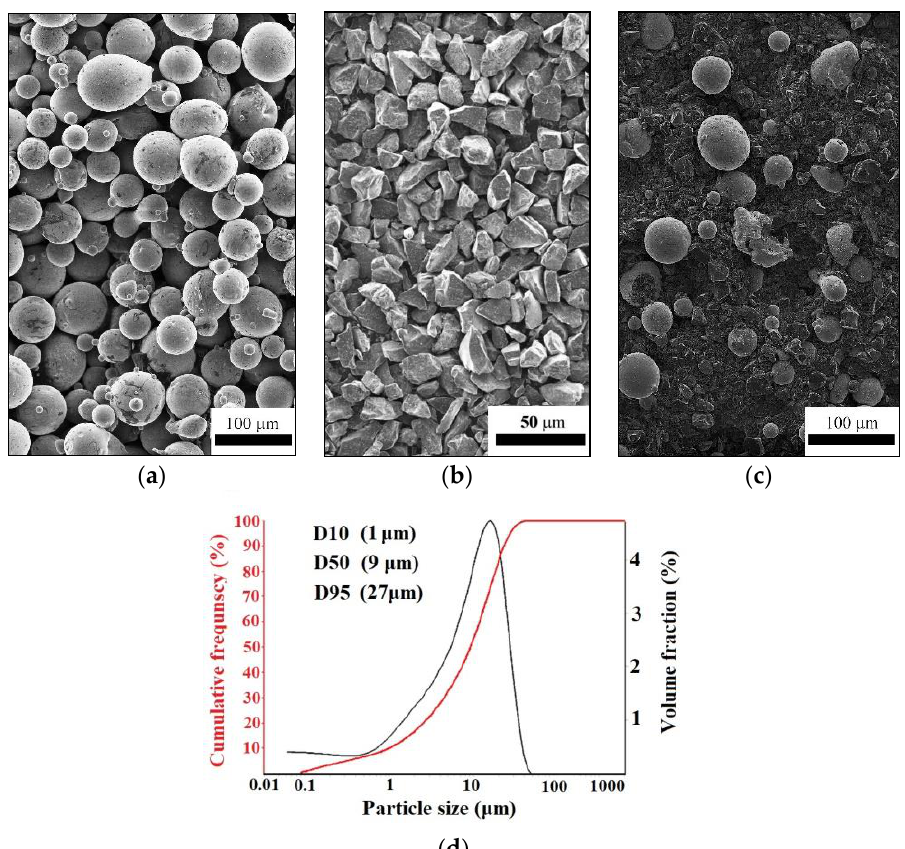
Figure 1. Morphology and particle size of the initial powders and their compositions. Powder morphologies: AP-NiCr17Si4B4 ( a ), B 4 C ( b ) and their composition after mixing ( c ). Particle size distribution of NiCr-70B 4 C powder composition ( d ).